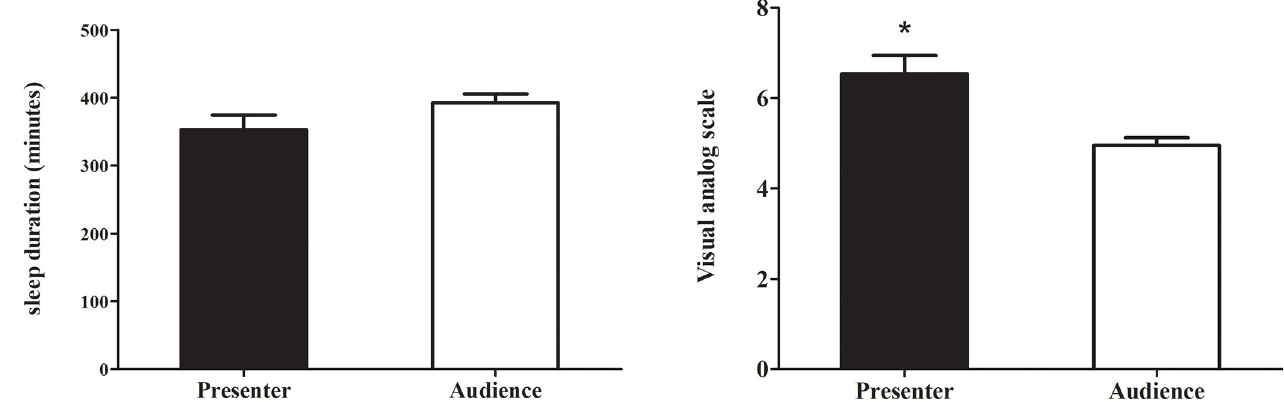
Fig 3. VAS scores and sleep duration between presenters and audience. Data were presented as mean ± SEM. � p < 0.001 compared with audience.